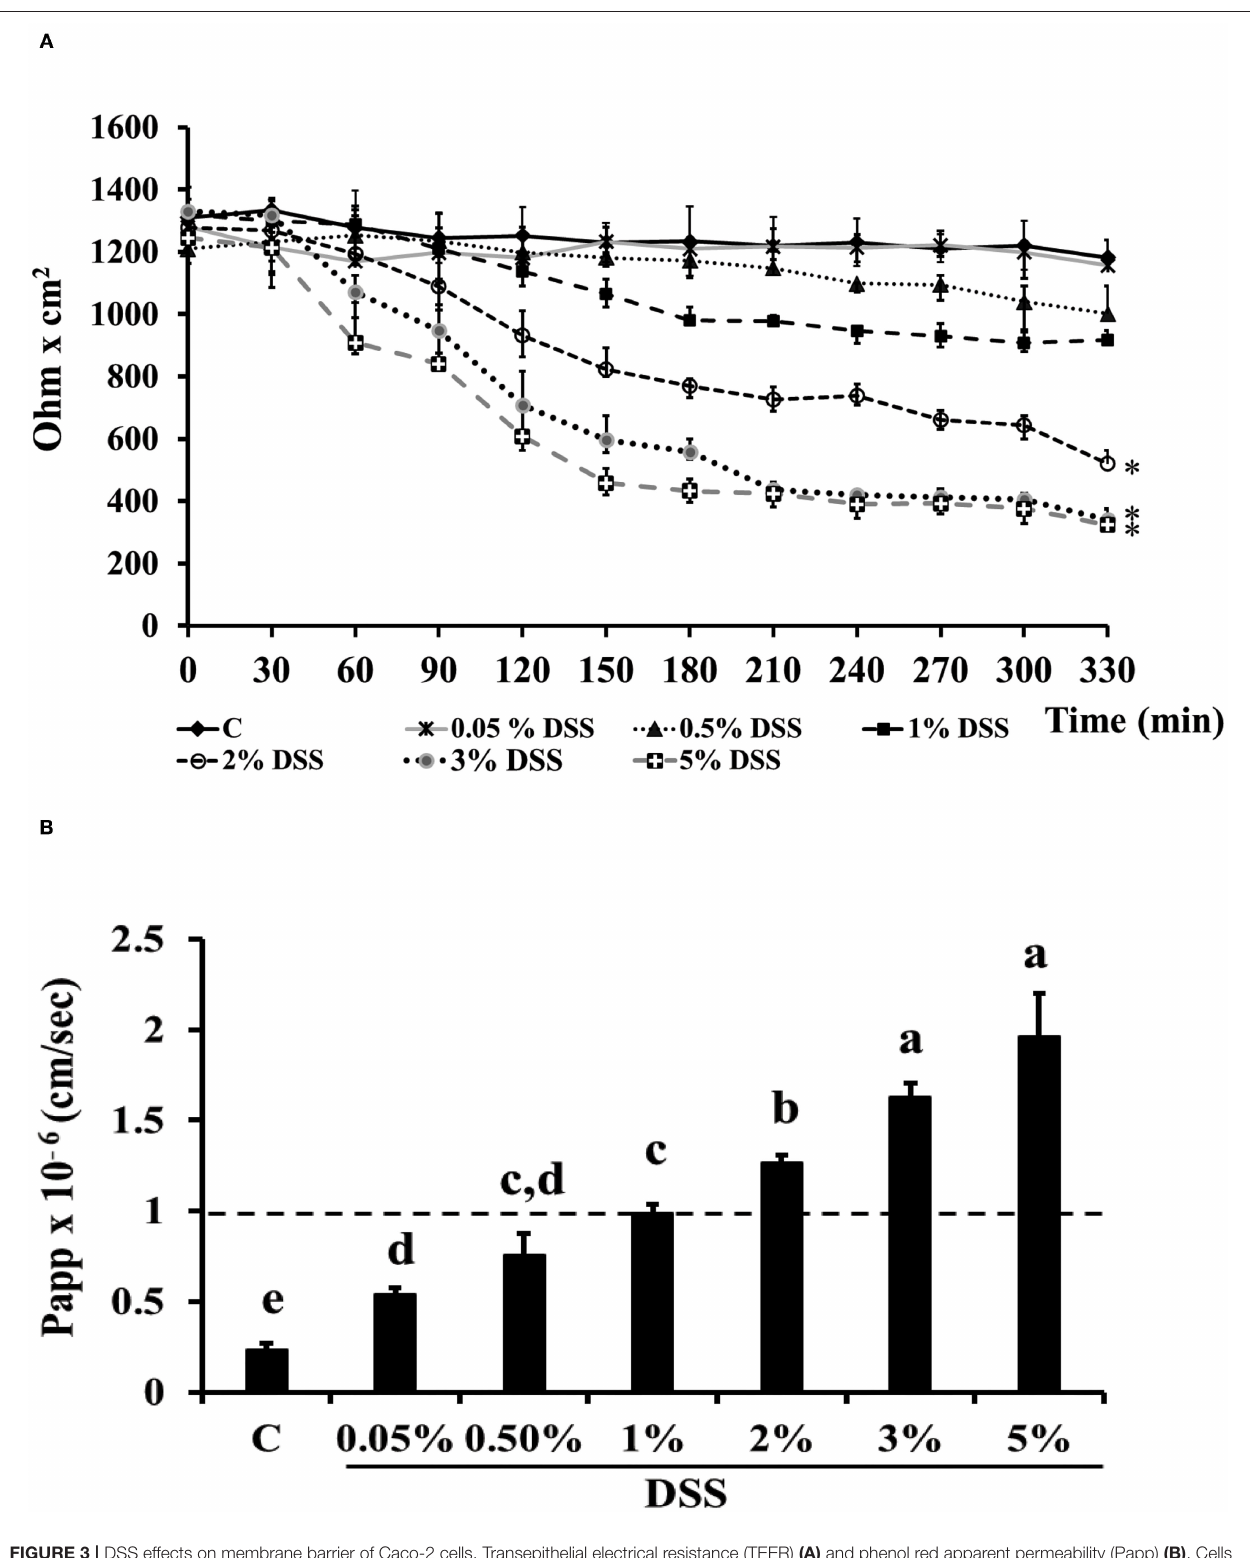
FIGURE 3 | DSS effects on membrane barrier of Caco-2 cells. Transepithelial electrical resistance (TEER) (A) and phenol red apparent permeability (Papp) (B) . Cells were either untreated (Control, C) or treated with different DSS concentrations (0.05–5%) for 330min. TEER values are reported as Ohm × cm 2 . Phenol red Papp was measured at end of TEER measurements, and values are reported as cm/sec. Values represent mean ± SD of at least three independent experiments, carried out in triplicate. (A) *Stands for significant difference between T0 and T330 ( P < 0.001). (B) Means without a common letter significantly differ, P < 0.05.